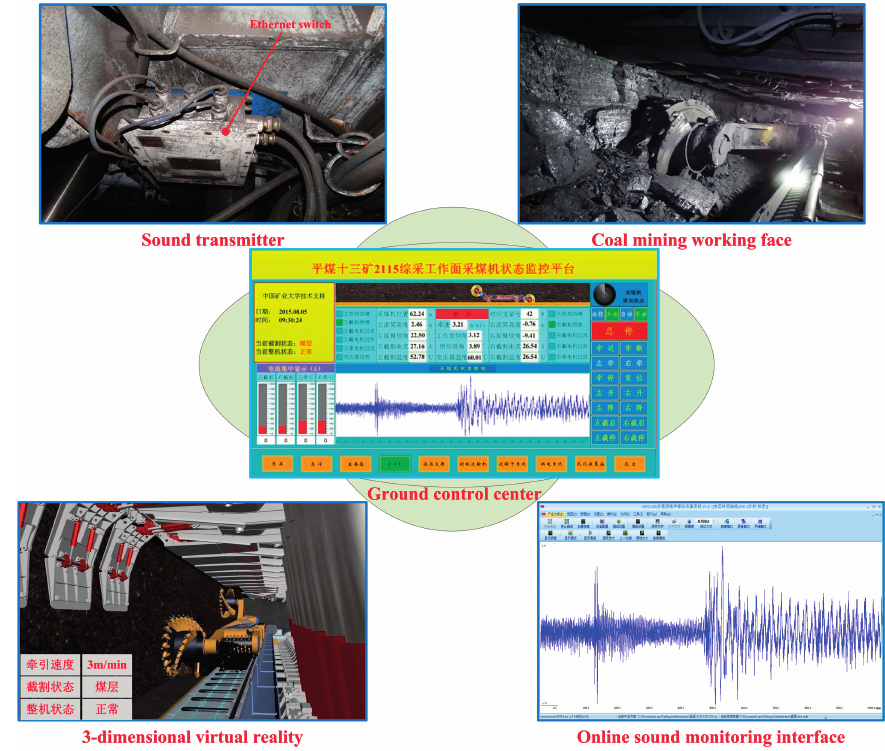
Figure 7. Industrial application of the proposed method.